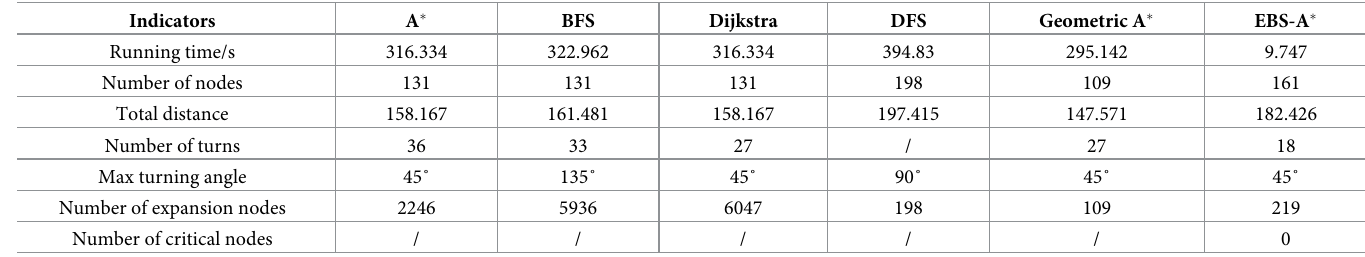
Table 9. Algorithm performance